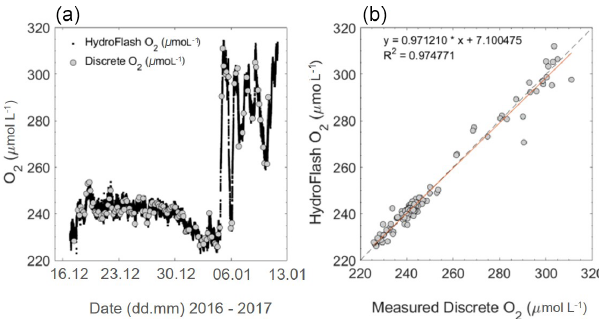
Figure 10. Oxygen concentration during cruise M133 from recal- ibrated continuous optode and discrete Winkler titration measure- ments (a) and a property–property plot (b) . For the open ocean and shelf waters, the mean offset is − 0 . 08 ± 1.89 ( ± SD)µmolL − 1 and − 0 . 15 ± 6.49 ( ± SD)µmolL − 1 , respectively. Higher variability to- wards the end of the transect is due to entering the productive Patag- onian Shelf (06.01.2017–13.01.2017), which is also seen in higher concentrations of O 2